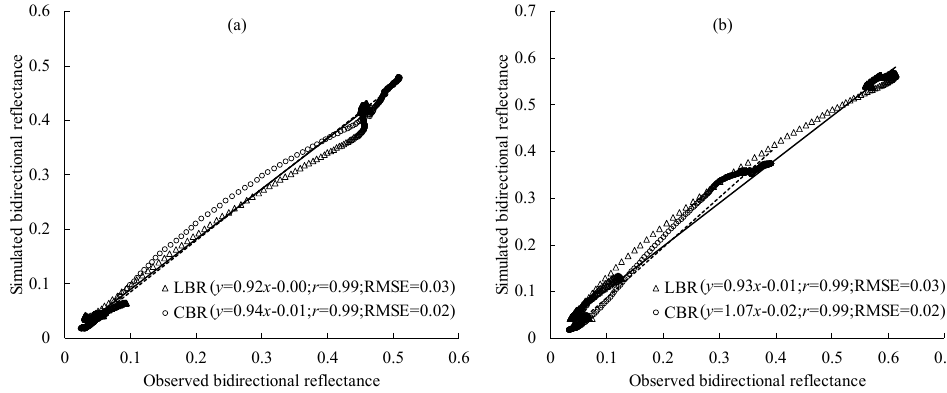
Figure 5. The scatter of observed and simulated bidirectional reflectance in the MBF ( a ) and LBF ( b ).